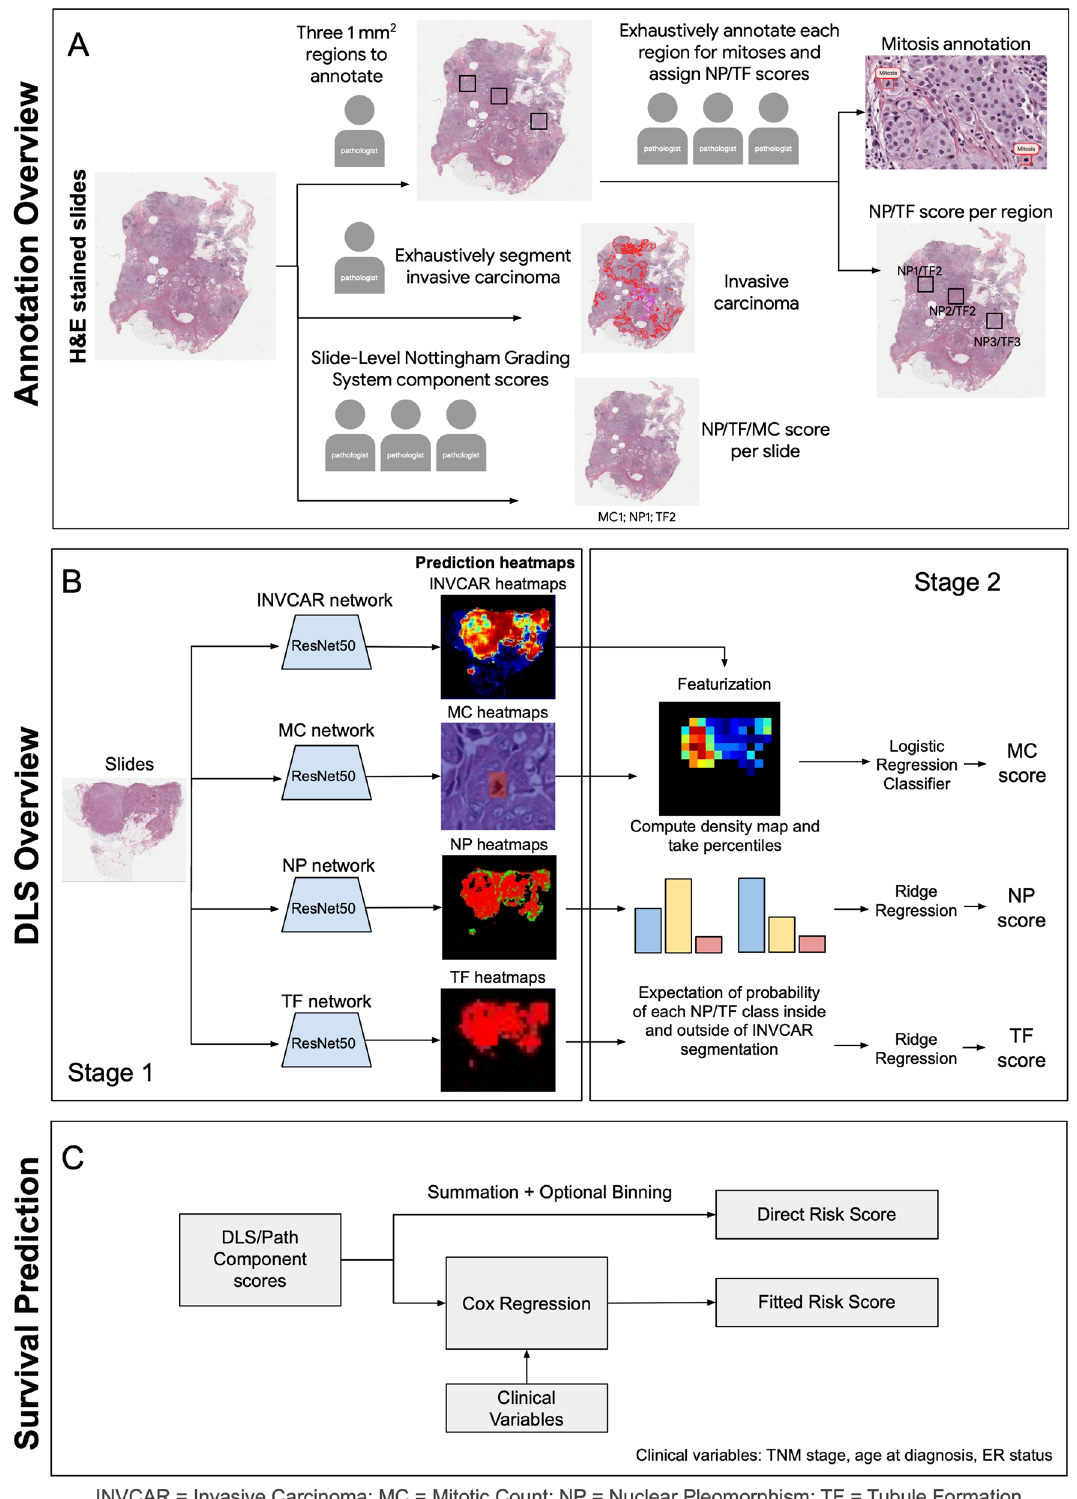
Fig. 1 Overview of annotation, deep learning system (DLS) development, and prognostic evaluation. A Annotation Overview: Pathologists provided annotations at a region-level and slide-level for all components of the histologic grade, including identi fi cation of individual mitotic fi gures. B DLS overview: convolutional neural network models were developed for invasive carcinoma (INVCAR) as well as all three components of the histologic grading system. These patch-level models were used as input to stage 2 models to provide a component score at the slide level for each feature. C Prognostic evaluation: Component grade scores provided by the DLS or pathologists were used to fi t Cox models for evaluation and comparison of prognostic